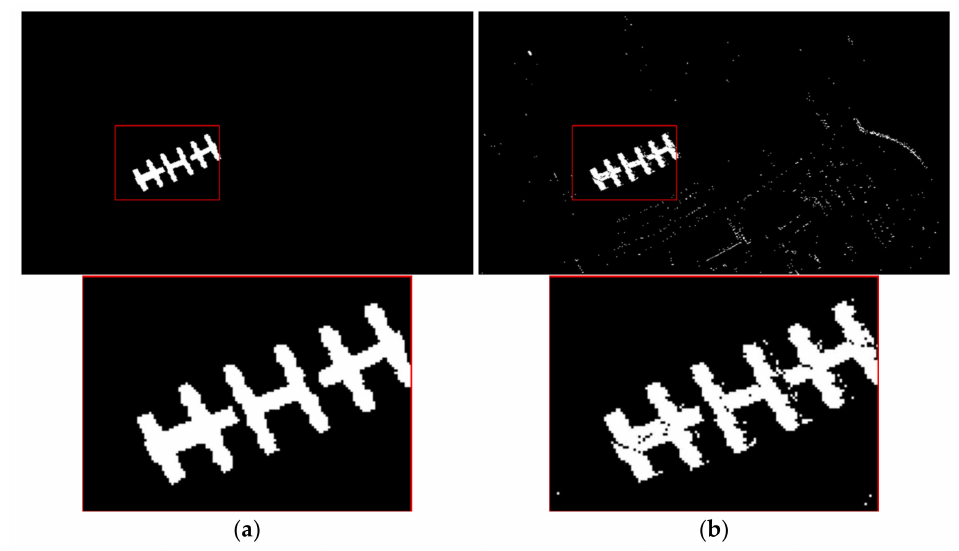
Figure 10. Extraction results of metal and partial enlarged image: ( a ) Ground truth information; ( b ) BAND22 extraction result.